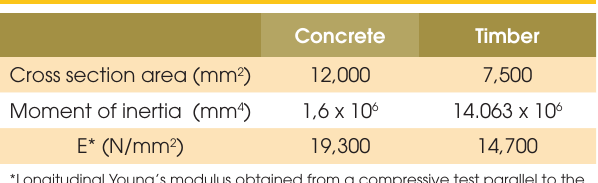
Table 1 – Properties of the components of the composite beam Concrete Timber